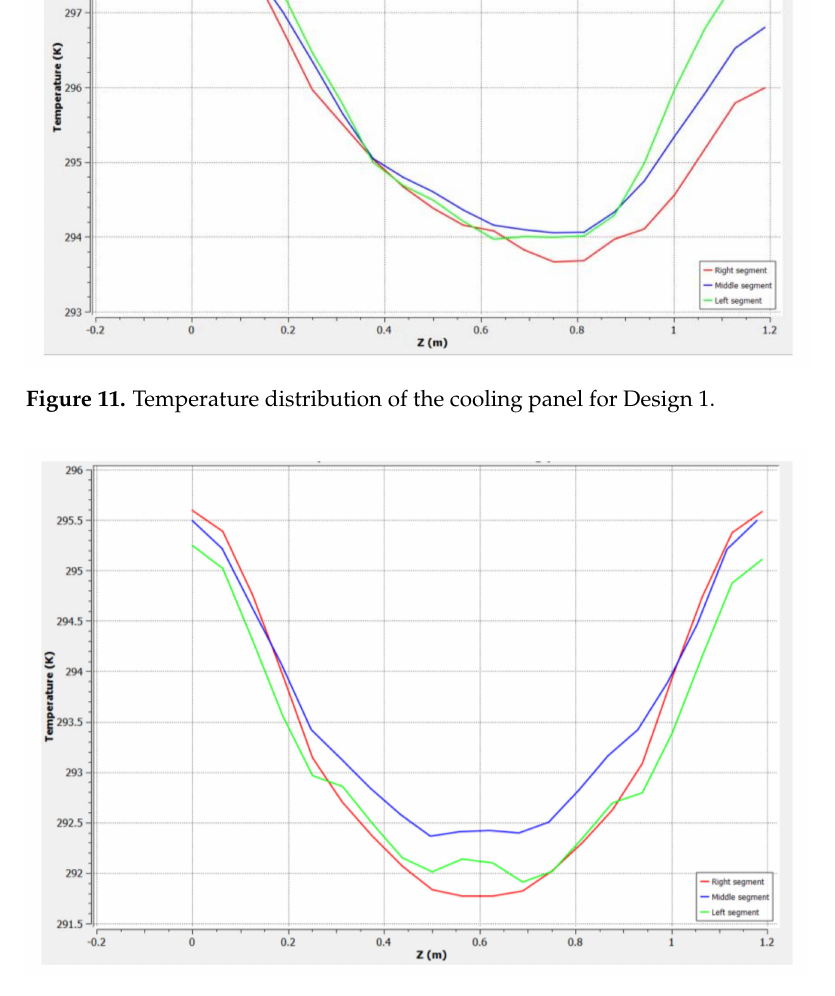
Figure 12. Temperature distribution of the cooling panel for Design